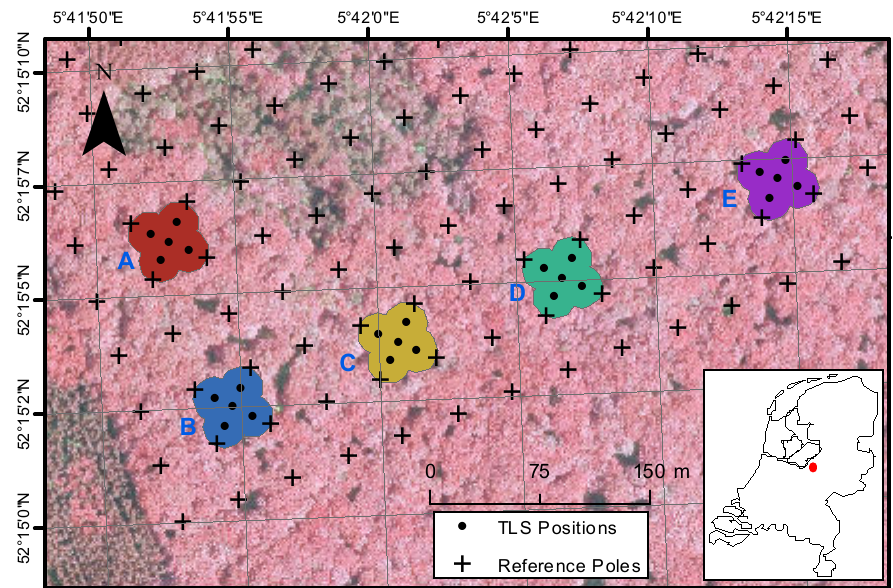
Figure 1. Speulderbos study site with TLS scan positions and polygons representing the five plots. Background image is an airborne false-colour composite of 2013. The inset shows the location of the study site within the